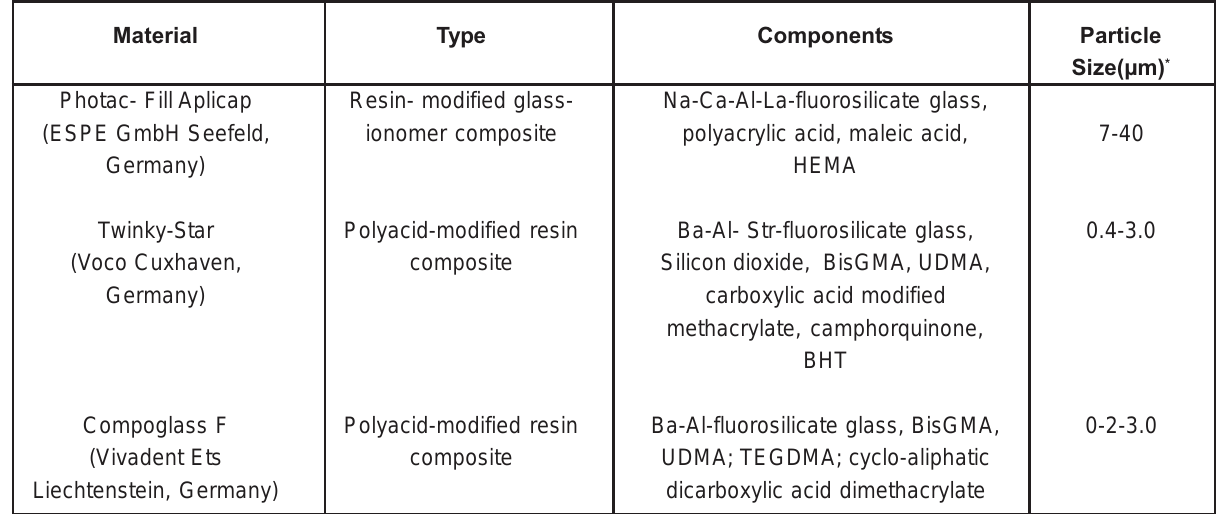
Figure 1- Manufacturers, types and components of the restorative materials used in